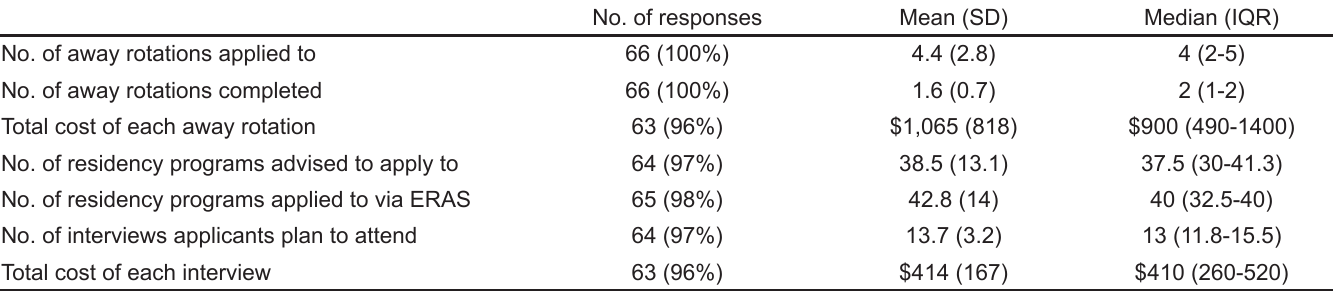
Table 1. Selected fourth-year medical students survey response data regarding costs incurred for away rotations and application to residency.